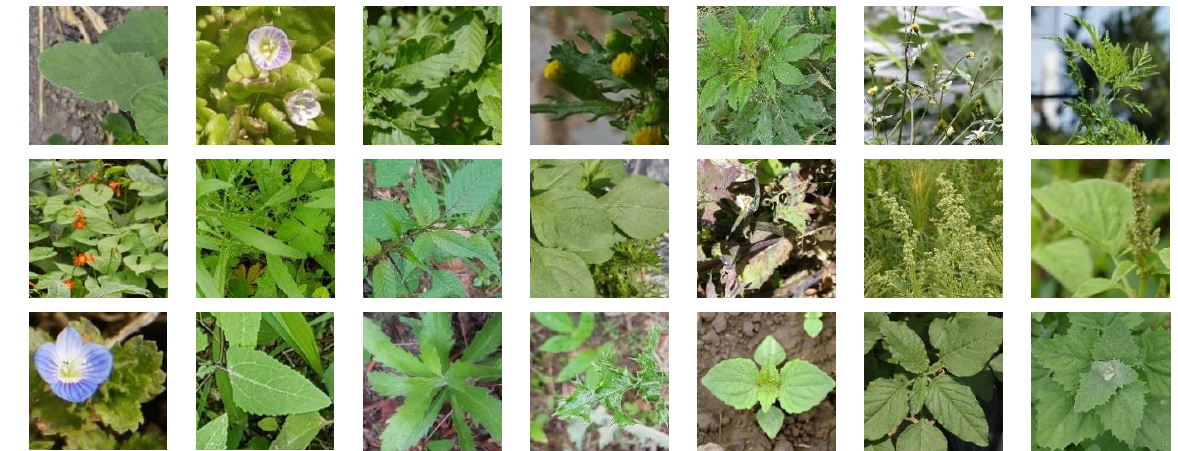
Figure 6. Examples of the 21 species in the Chonnam National University (CNU) weeds dataset. The order of species (left to right, top to bottom) corresponds to the labels (from left to right) in Figure 5.